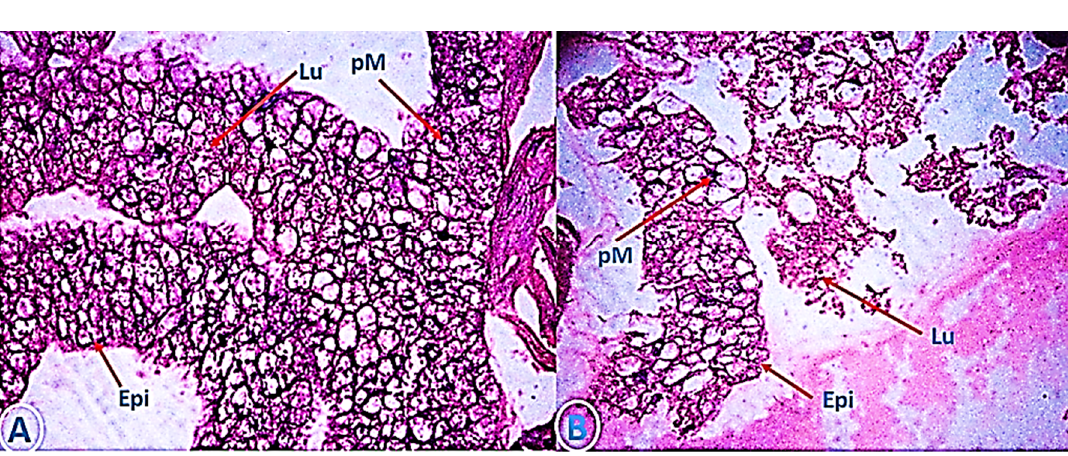
Figure 5. ( A ) α-carboxylestrase; ( B ) β-carboxylestrase; ( C ) SOD; ( D) GST; ( E ) CYP450 enzyme activity of third and fourth instar larvae of Ae. aegypti after treatment with My-It. The data were fitted on a polynomial (regression) model. Letters (a-d) mean (± SE) followed by the same letters above bars indicated no significant difference ( p ≤ 0.05) using ANOVA analysis.